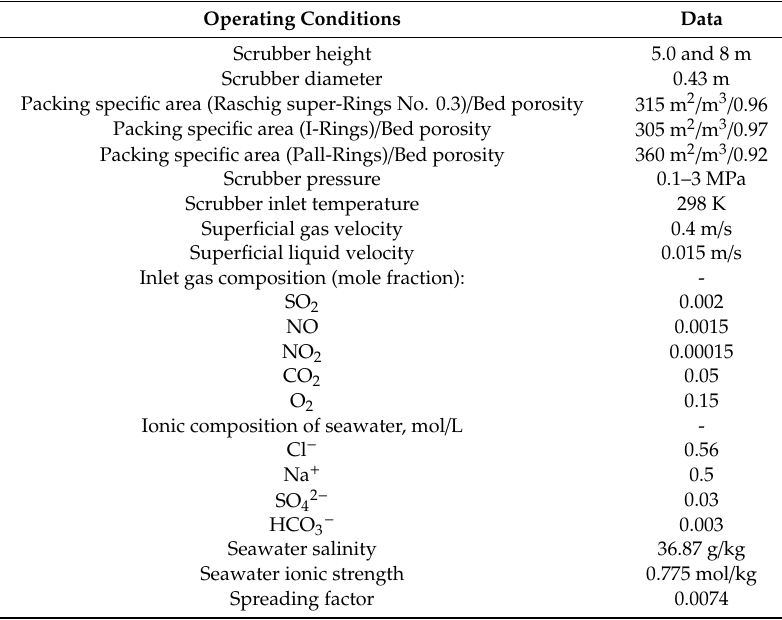
Table 2. Parameters used in simulations.